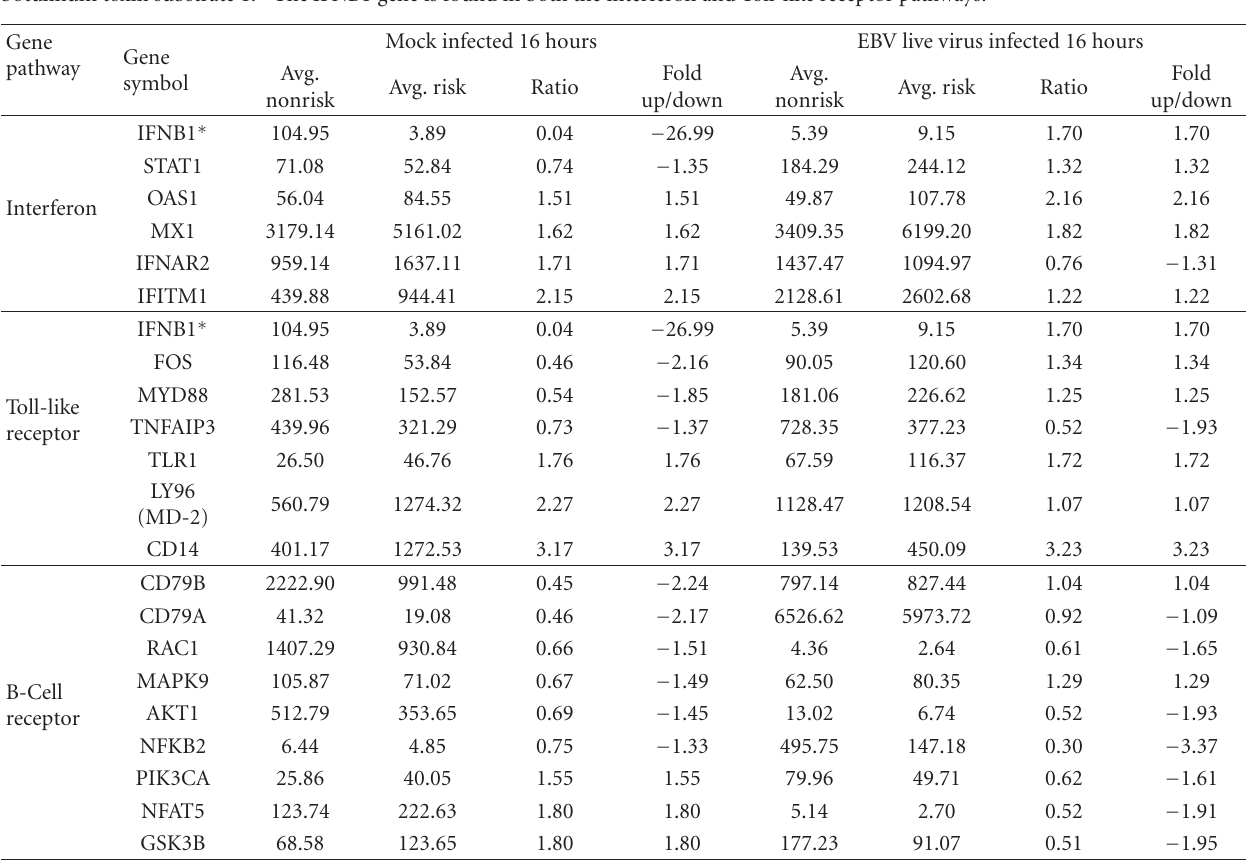
Table 3: Genes exhibiting di ff erential expression between risk and nonrisk cells in the canonical pathways identified through ingenuity pathway analysis. Fold up/down column is positive in the case that the gene expression is higher in the risk haplotype cells, and negative in the case that gene expression is higher in the nonrisk cells. PIK3CA: phosphoinositide-3-kinase, catalytic, alpha; RAC1: Ras-related